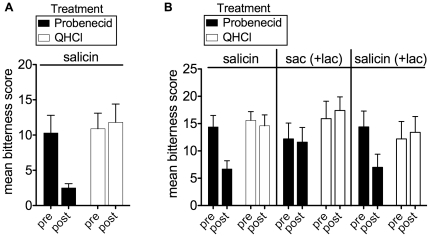
Suppression of human bitterness perception of salicin by probenecid.(A) 15 human subjects were asked to rate the bitterness intensity of 10 mM salicin before (pre) and after (post) treatment with 10 mM probenecid or control treatment with 8.1 µM quinine HCl (QHCl) on a general labeled magnitude scale (gLMS). Treatment with probenecid (black bars) significantly inhibited the perceived bitterness of salicin (p<0.05), whereas a bitter taste control treatment with QHCl had no affect (white bars). (B) 9 human subjects were asked to rate the bitterness intensity of 10 mM salicin or 250 mM saccharin before (pre) and after (post) treatment with 10 mM probenecid or control treatment with 8.1 µM quinine HCl (QHCl). Treatment with probenecid (black bars) significantly inhibited the perceived bitterness of salicin (p<0.05), whereas a control treatment with QHCl had no affect (white bars). Probenecid failed to inhibit the bitterness of saccharin (in the presence of the sweet taste inhibitor lactisole (lac) to enable subjects to focus exclusively on the bitterness of saccharin). The inhibitory effect of probenecid on salicin was also observed in the presence of lactisole, demonstrating that lactisole did not interfere with probenecid's inhibition of perceived bitterness. At the concentrations used, salicin and saccharin did not differ in their overall perceived bitterness. Error bars represent standard errors (SE).